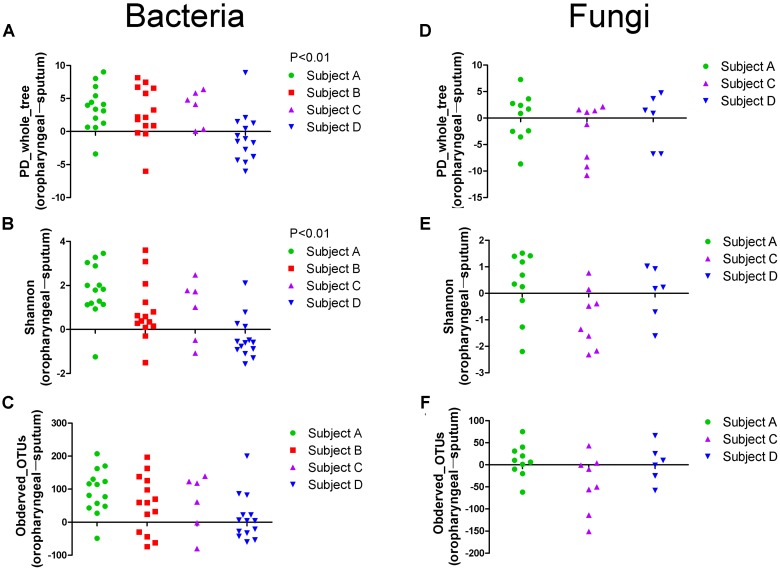
Scatter plot showing the alpha diversity measurements of the microbiota collected from the oropharyngeal and sputum samples. (A) PD_whole_tree, (B) Shannon and (C) Observed_OTUs indices of bacterial community. (D) PD_whole_tree, (E) Shannon and (F) Observed_OTUs indices of fungal community. For each patient, swab samples are compared to sputum samples from different days. Each point represents a difference between the oropharyngeal swab and sputum sample, as determined using a simple up/down scoring system whereby on each subject-day, the sample with the higher diversity was recorded (obtained using the Chi-square test). PD_whole_tree, Observed_OTUs, and Shannon indices were used as phylogenetic, richness, and evenness and richness metrics, respectively, to determine the diversities of the bacterial and fungal communities.